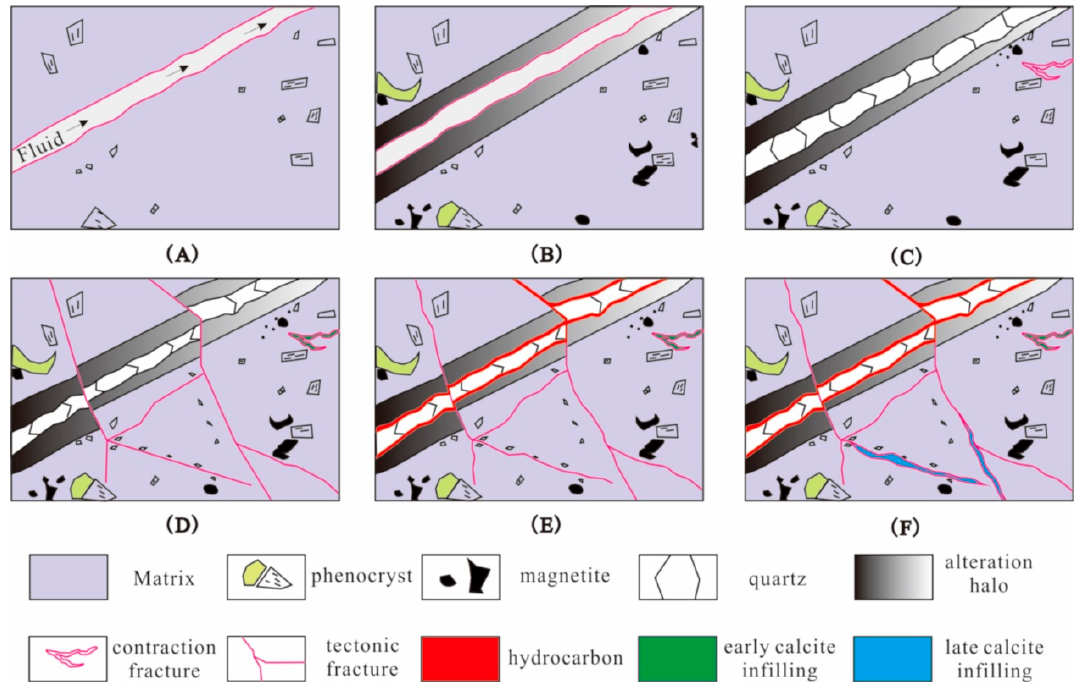
Figure 9. Conceptual model for fracture evolution of the volcanic rocks of the Carboniferous Batamayineishan Formation of the Kelameili Gas Field. ( A ) Hydrothermal fluids infilling; ( B ) migration of elements; ( C ) quartz veins and early calcite formed; ( D ) tectonic fractures formed; ( E ) hydrocarbon emplacement; ( F ) late calcite precipitation.